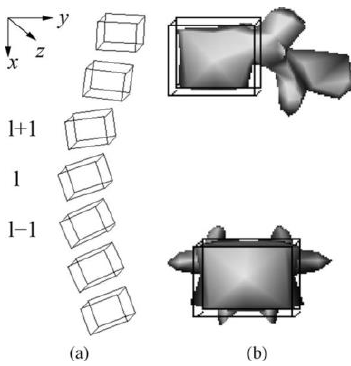
Figure 7. Crude prior model of the spine. (a) Deformable model of the whole spine and (b) cubic template representation associated with each vertebra; Source: (Benameur et al., 2005)